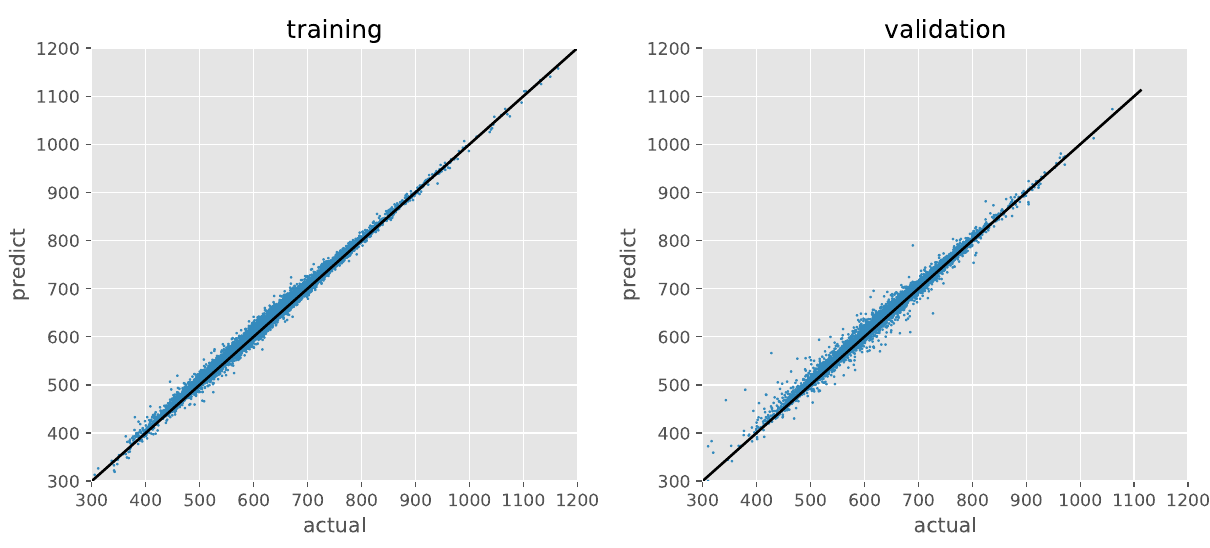
Fig 3. Actual and predicted grain yields in training and validation. MSE between the actual and predicted values is 52.9 and 81.7 in the training and validation processes, respectively.